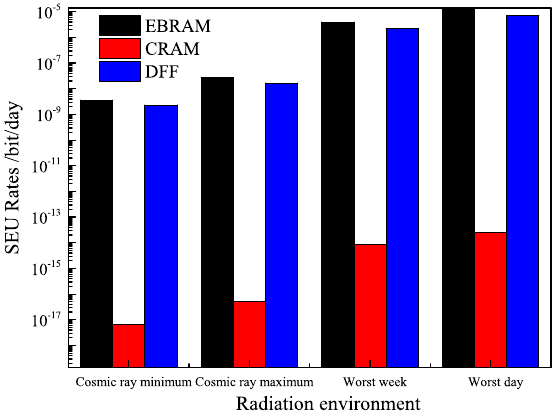
Figure 12. Creme results: SEU rates in isotropic GEO environment behind 3 mm aluminum